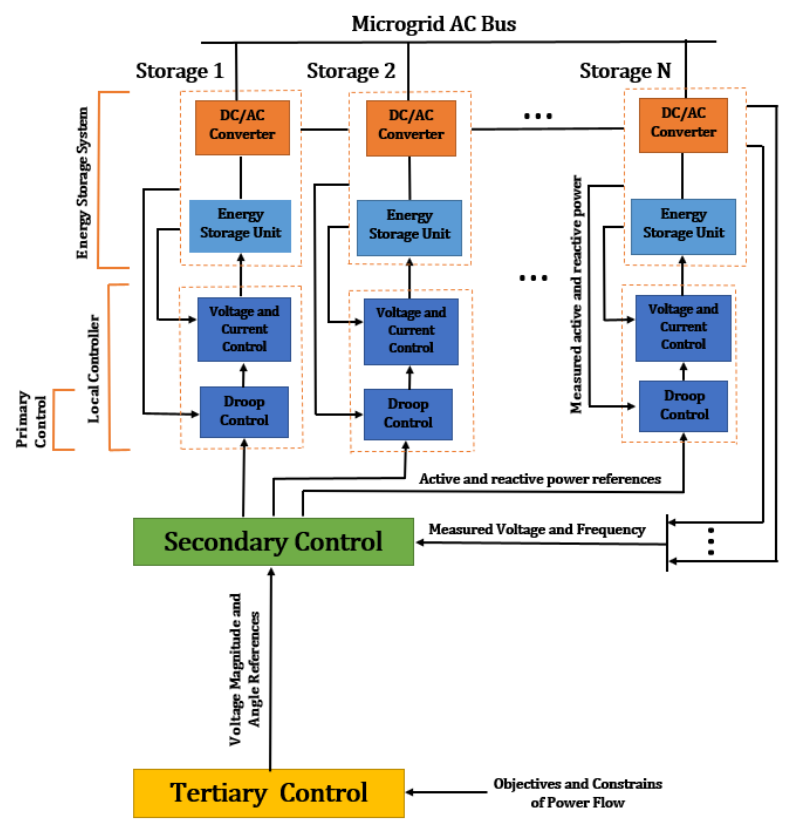
Figure 1. Hierarchical control architecture of AC microgrid.